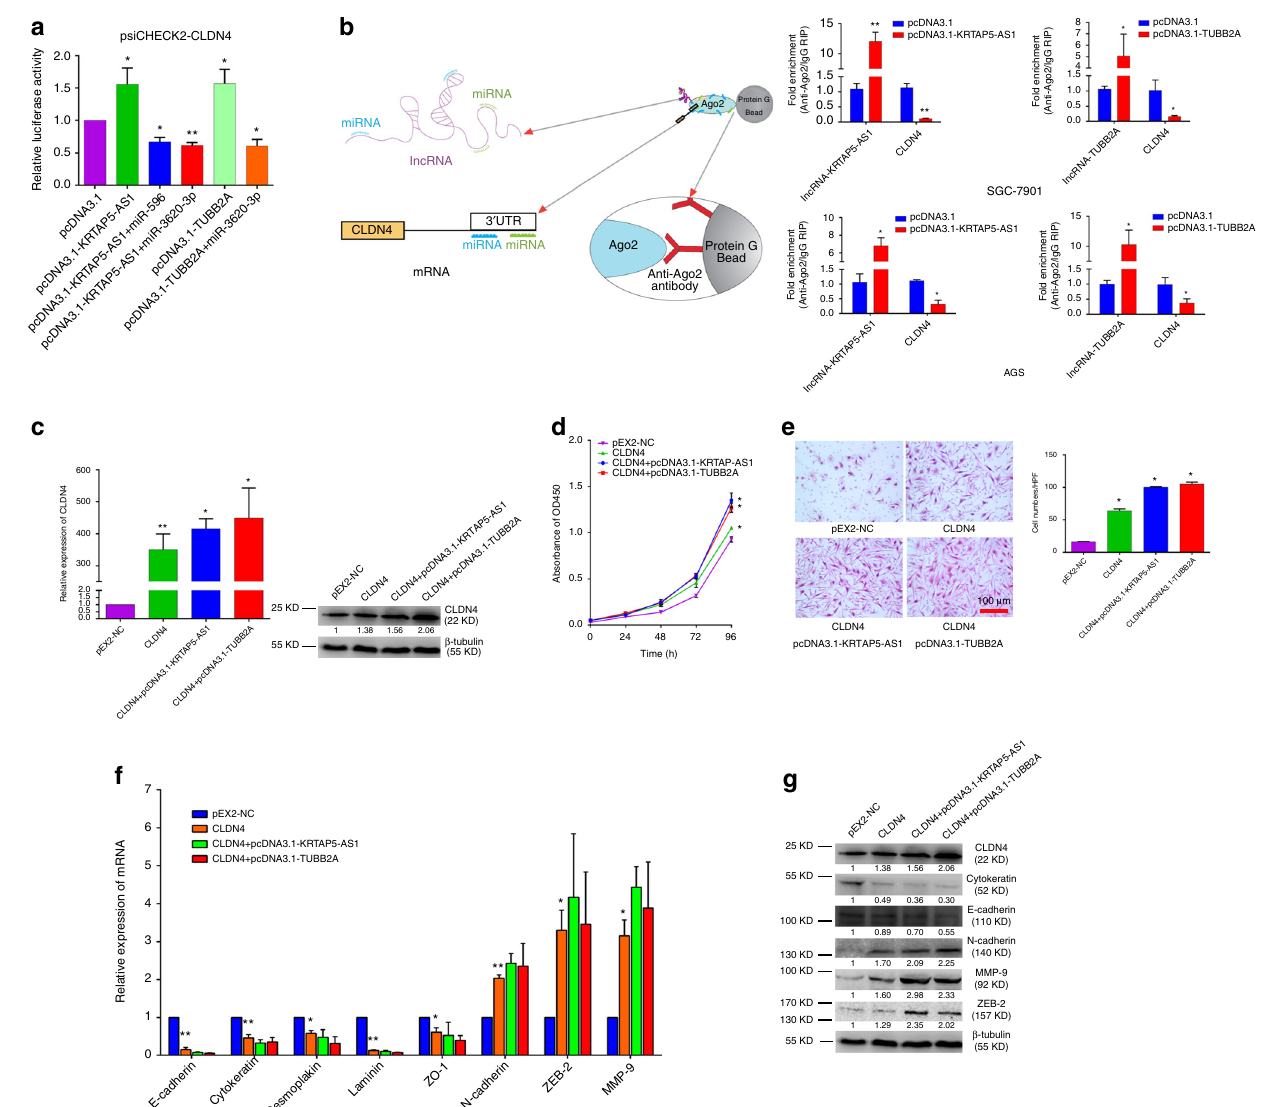
Fig. 6 LncRNA-KRTAP5-AS1 and LncRNA-TUBB2A act as ceRNAs. a Luciferase activity in GC cells co-transfected with psiCHECK2-CLDN4 and ceRNAs. Data were presented as the relative ratio of renilla luciferase activity and fi re fl y luciferase activity. b The schematic diagram and real-time PCR results of the RIP based on Ago2 showed that lncRNAs can compete with the CLDN4 transcript for the binding of miRNAs. c The relative expression levels of CLDN4 were determined by real-time PCR and western blotting after co-transfecting ceRNAs. d Cell proliferation was assessed daily for 4 days using the CCK-8 assay in CLDN4 overexpressed cells transfected the plasmids of pcDNA3.1-KRTAP5-AS1 and pcDNA3.1 -TUBB2A. e Transwell assays were used to assay the involvement of CLDN4 for invasion in CLDN4 overexpressing cells. Cells were incubated for 24 h, and counted under the microscope. Original magni fi cation ×200. Scale bars = 100 μ m. f , g The transcriptional and translational levels of EMT related markers. The real-time PCR and western blotting were performed at 48 h after the CLDN4 overexpressing cells treated with pcDNA3.1-KRTAP5-AS1 and pcDNA3.1-TUBB2A. Data are shown as mean ± s.d., n = 3. The data statistical signi fi cance is assessed by Student ’ s t -test. * P < 0.05, ** P <